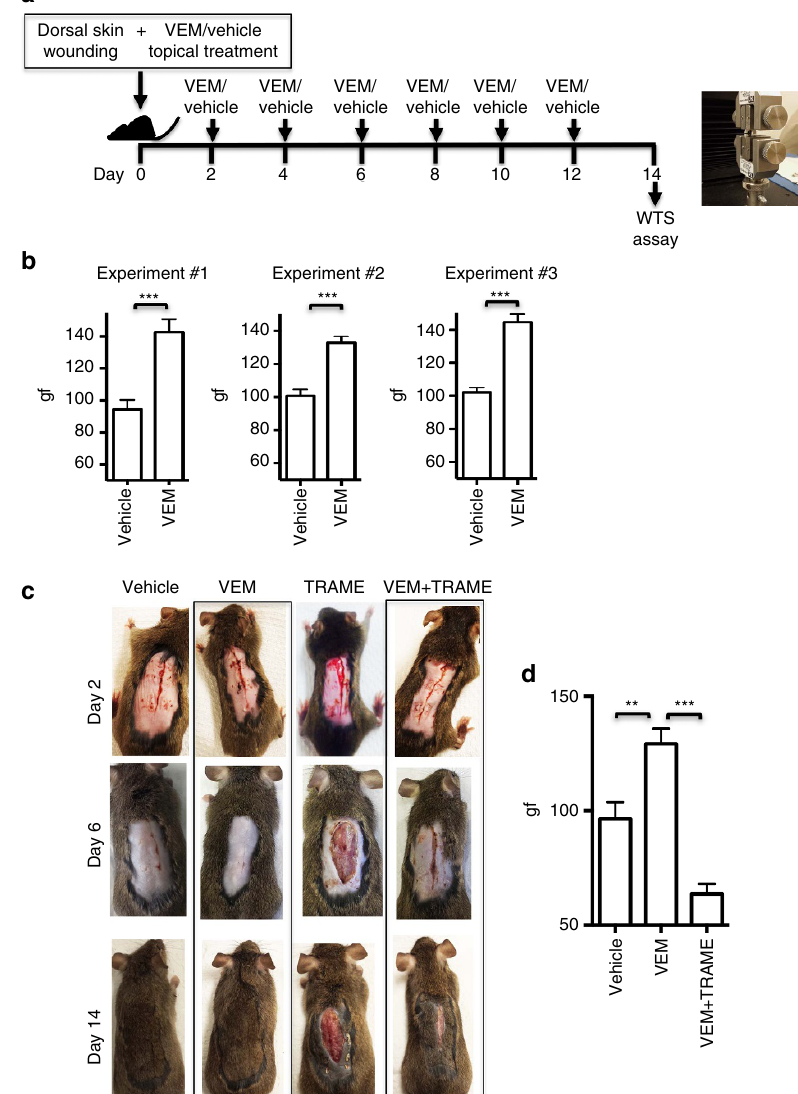
Figure 2 | BRAF inhibition accelerates and MEK inhibition suppresses wound healing. ( a ) Schematic representation of the wound-healing studies performed in C3H mice. ( b ) Wound tensile strength (WTS) using 2mm strips of wound-containing skin in three replicate experiments, each with eight mice per group. WTS is represented as gram force (gf) per 2mm strip ( P o 0.0001). ( c ) Representative images of mice treated topically with vehicle, vemurafenib (VEM, 2mg), trametinib (TRAME, 0.2mg) and the combination of vemurafenib and trametinib (VEM þ TRAME) on days 2, 6 and 14. ( d ) WTS in 8 mice per group, as gram force (gf) comparing vehicle, vemurafenib and the combination of vemurafenib and trametinib ( P o 0.0001). Error bars in b and d , mean ± s.d.; n ¼ 8. Every graph represents one experiment with 8 cytometry (Fig. 1c,d and Supplementary Fig. 6). Vemurafenib decreased pERK in the BRAF V600E mutant human melanoma cell line M249, as expected, whereas it induced a paradoxical increase in pERK in HEKa cells. Furthermore, in the presence of vemurafenib, the proliferative marker Ki67 decreased in M249